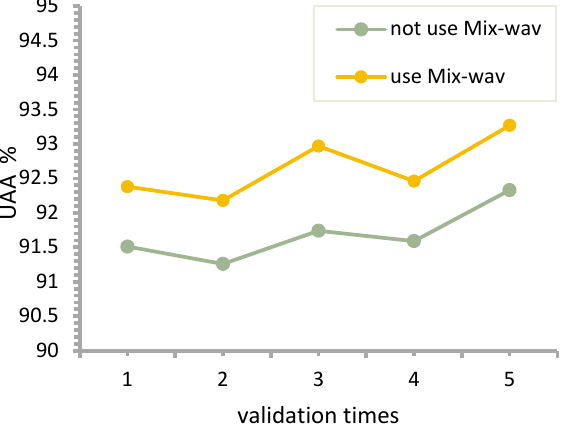
Figure 5. Comparison of tests before and after using Mix-wav on CHSE-DB.